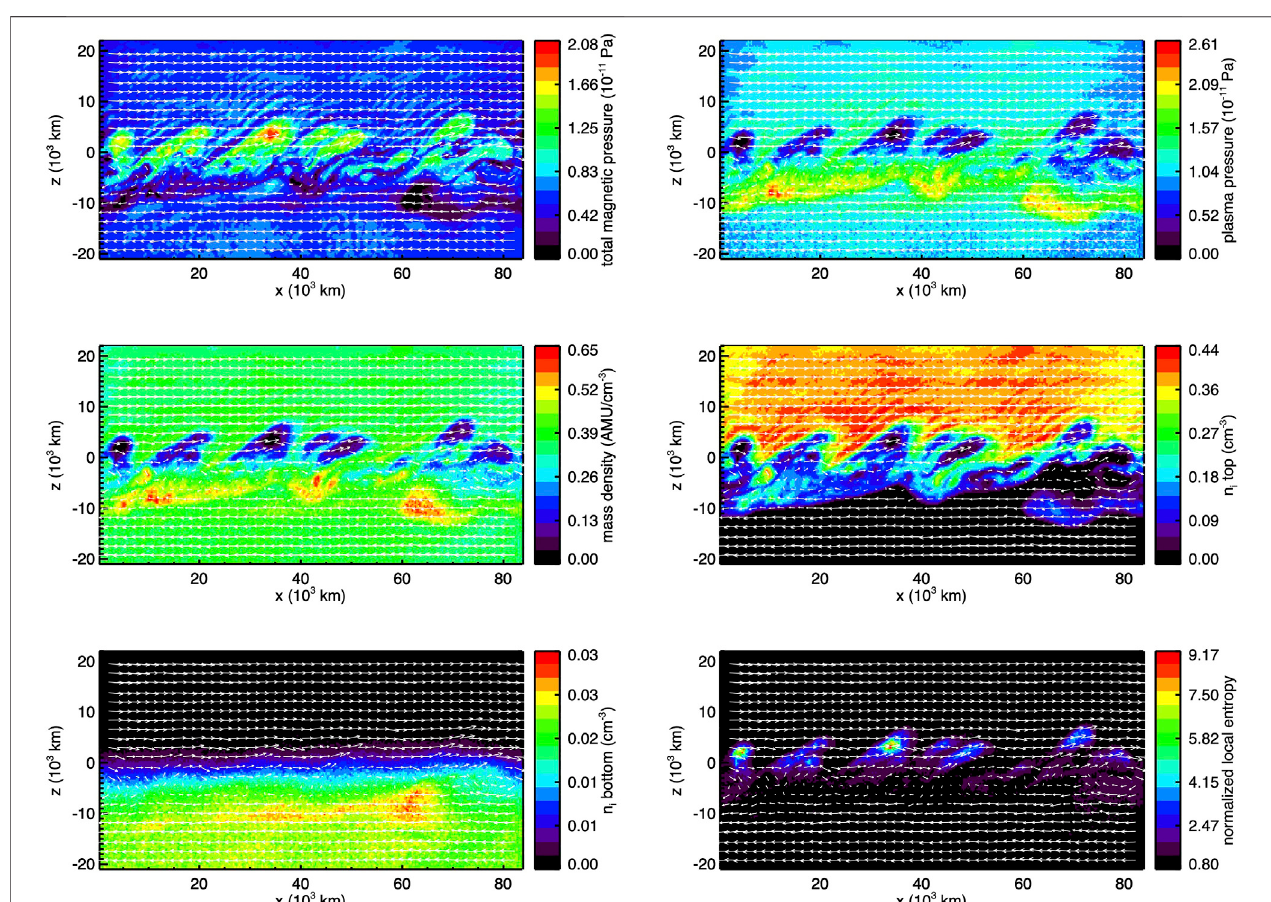
FIGURE12| KHwaveswithheavyions.Theprotonsareinitializedinthetophalfandtheheavies(17 amu)inthebottomhalfofthedomain.Fromtoptobottomand left to right: total magnetic pressure, plasma pressure, massdensity,ion density for thetop region(protons), ion density for the bottom region (heavies), normalized local